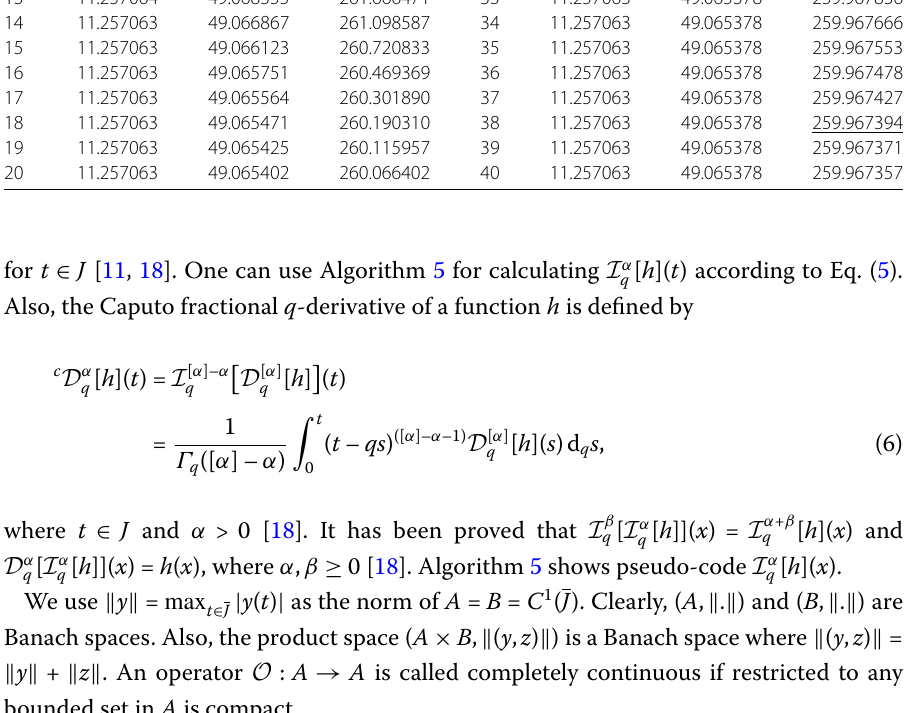
, 1 , 2 , and n = 1,2, ... ,40 of 3 2 3